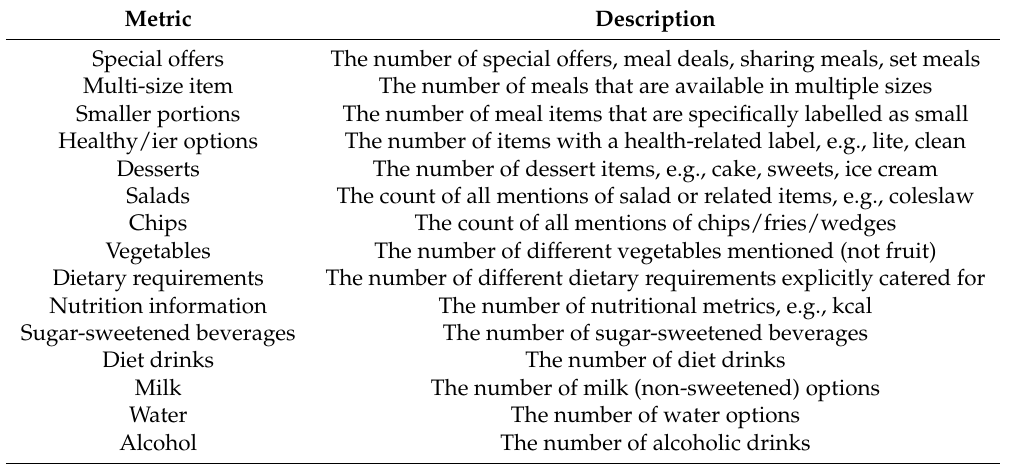
Table 1. Just Eat online menu items associated with health that are identifiable and